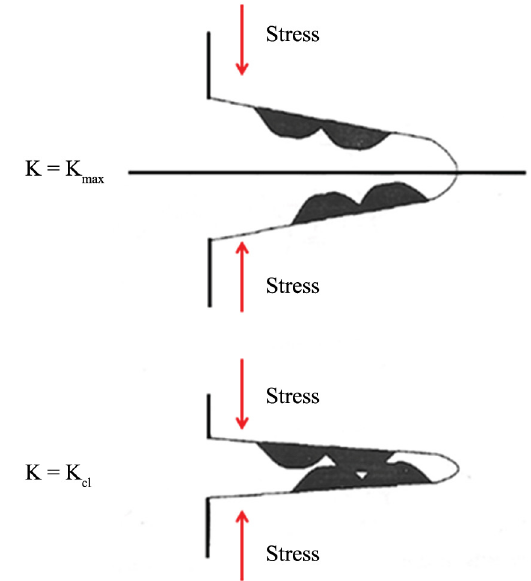
Figure 6. Schematic illustration of the wedging effect mechanism induced by corrosion products. Figure adapted from Komai 16